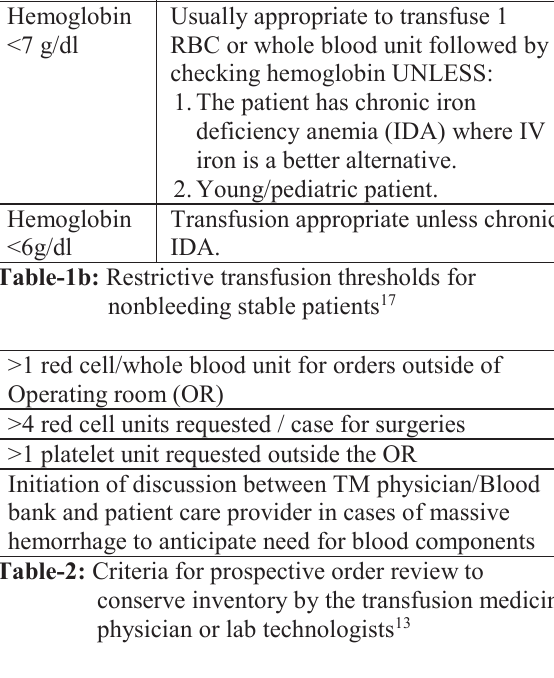
Table-2: Criteria for prospective order review